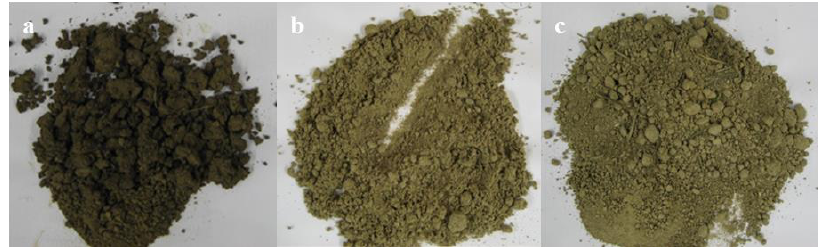
Figure 1. Soil samples collected from: ( a ); Escholzmatt (Coordinates UTM: 32T 418899; 5196217). ( b ); Orbe (Coordinates UTM: 32T 311,454; 5,178,043) ( c ); Zumikon (Coordinates UTM: 32T 471,589; 5,241,894).